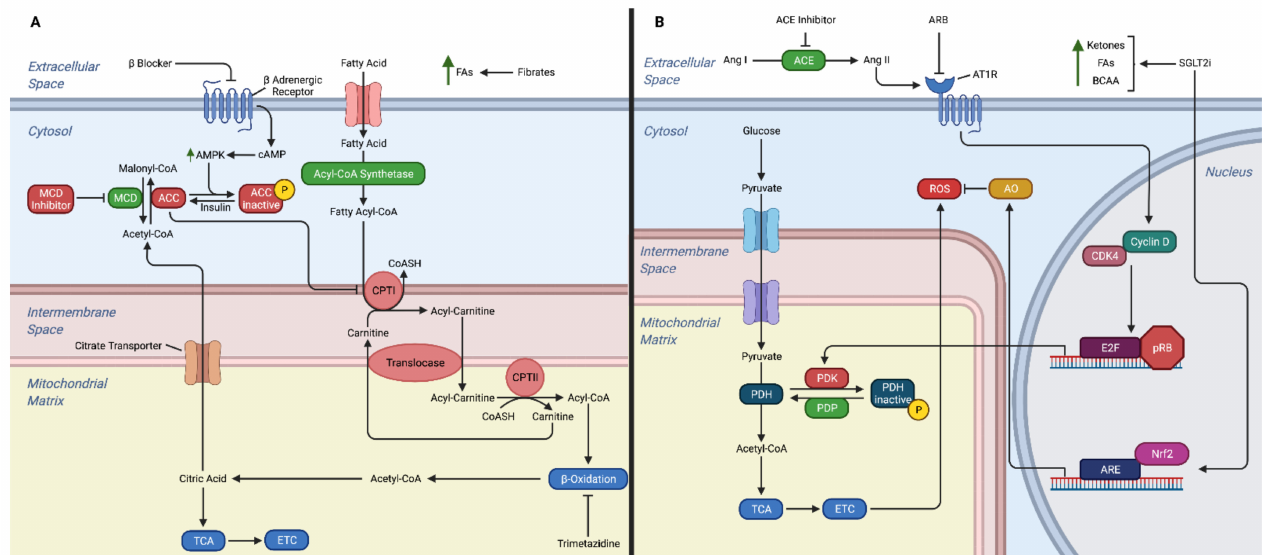
Figure 2. Mechanisms of action for heart failure medications on cardiac metabolism. ( A ) Fatty acid metabolism. ( B ) Glucose metabolism. The drugs shown in part A include β -blockers, fibrates, MCD inhibitor, and trimetazidine. Section B demonstrates the mechanisms of heart failure drugs on glucose metabolism and response to the production of ROS. The drugs shown in section B include ACE inhibitor, ARB, and SGLT2i. Abbreviations, ACE: angiotensin-converting